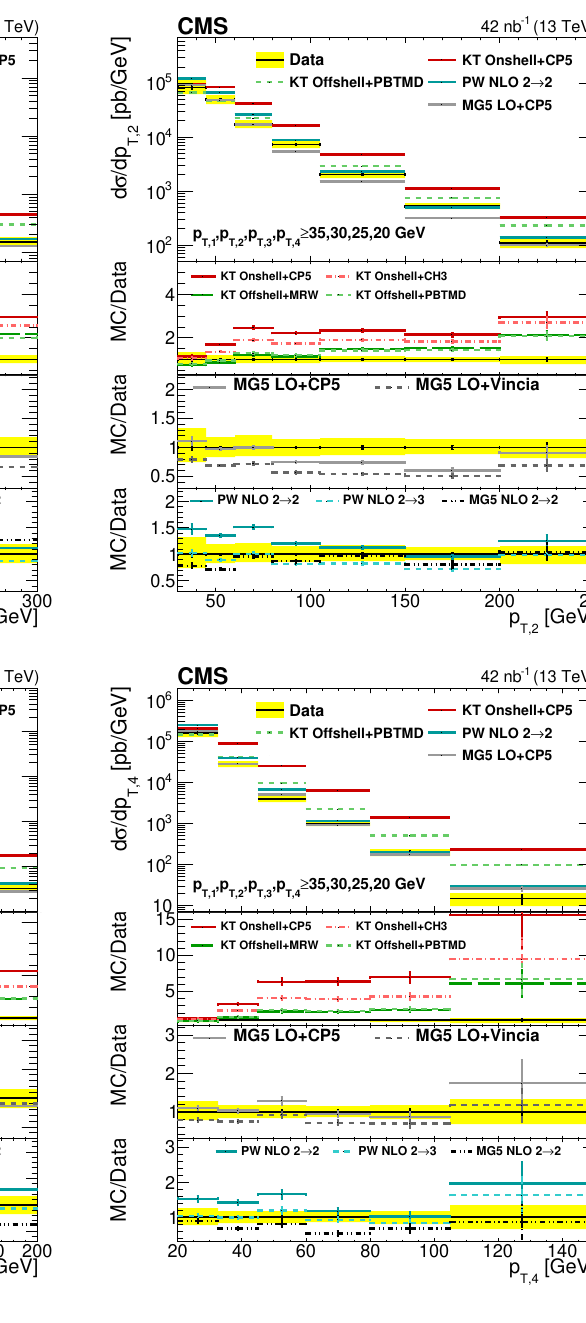
spectra of data with different KaTie (KT), Mad- Figure 6 . Comparison of the unfolded p T Graph 5_a mc@nlo (MG5), and powheg (PW) models, for the leading (upper left), subleading (upper right), third leading (lower left), and fourth leading (lower right) jet in Region I. The error bars represent the statistical uncertainty, and the yellow band indicates the total (statisti- cal+systematic) uncertainty in the